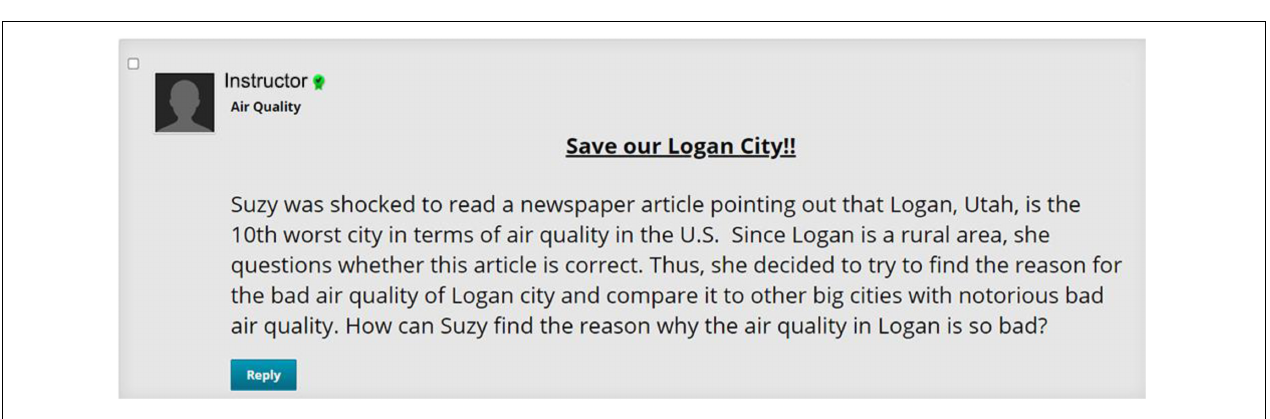
FIGURE 2 | Authentic